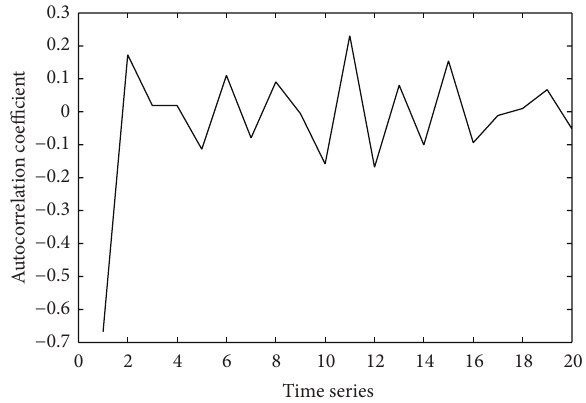
Figure 8: Autocorrelation